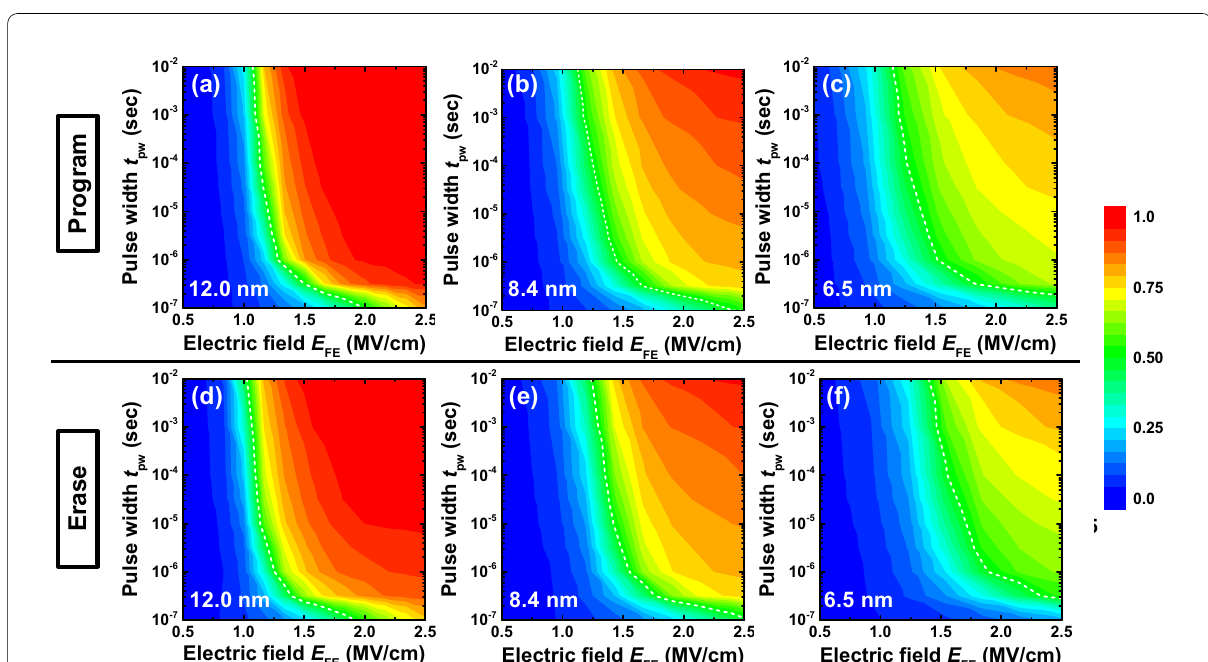
Fig. 5 Measured contour plots of normalized switching polarizations as a function of t pw and E FE for program operation with ( a ) 12.0 nm, ( b ) 8.4 nm, and ( c ) 6.5 nm-thick HZO capacitors, and for erase operation with ( d ) 12.0 nm, ( e ) 8.4 nm, and ( f ) 6.5 nm-thick HZO